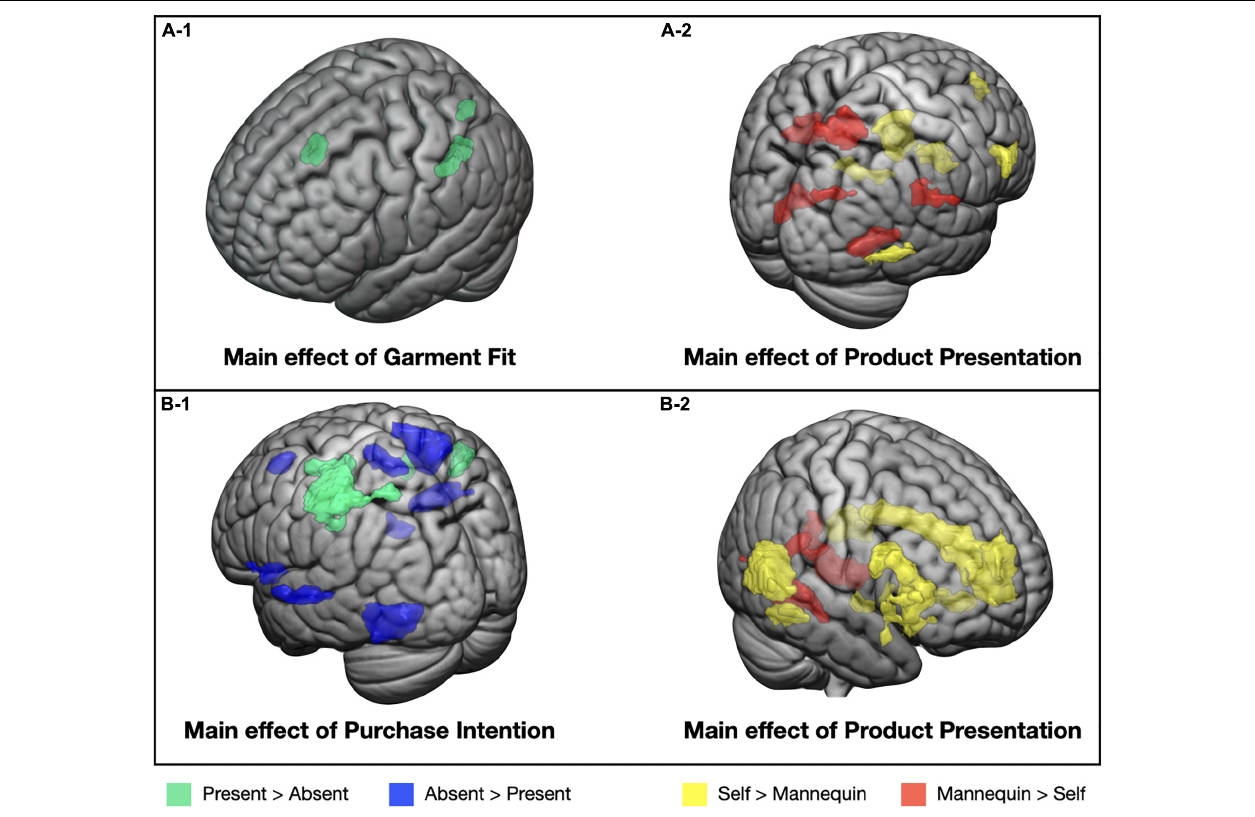
FIGURE 2 | An illustration of significant main effects from the univariate analysis. Significant neural clusters were illustrated for the main effects of garment fit (A-1) and product presentation (A-2) in Part 1 and for the main effects of purchase intention (B-1) and product presentation (B-2) in Part 2.